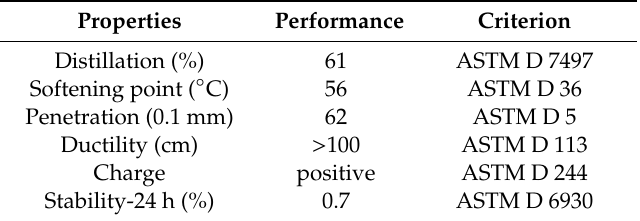
Table 2. Basic properties of modified emulsified